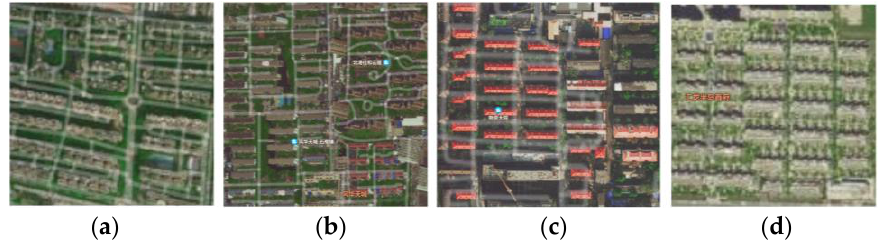
Figure 5. Residential area in cities of China. ( a ) Guangzhou, ( b ) Wuhan, ( c ) Beijing, ( d ) Harbin.